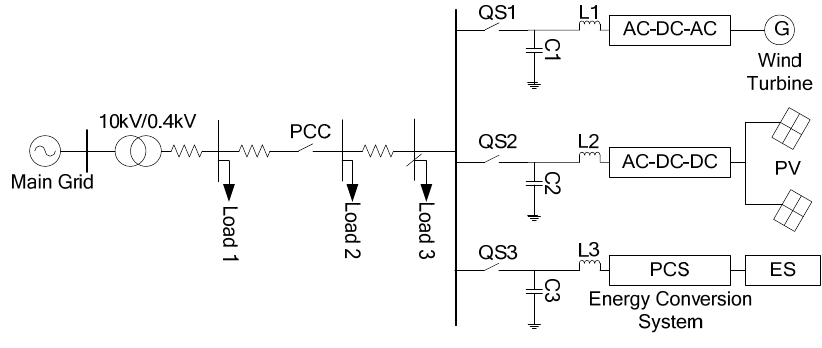
Figure 1. Structure of a micro ‐ grid system.